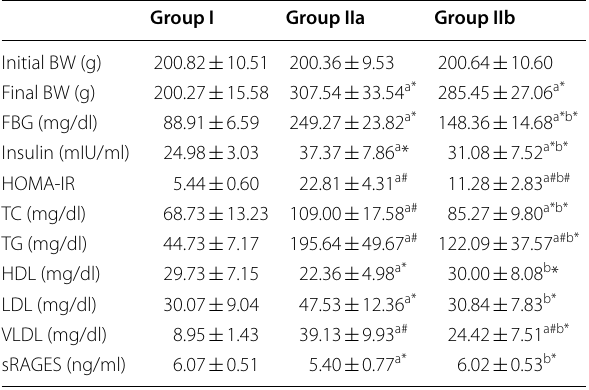
Table 1 Anthropometric and serum metabolic parameters in all groups